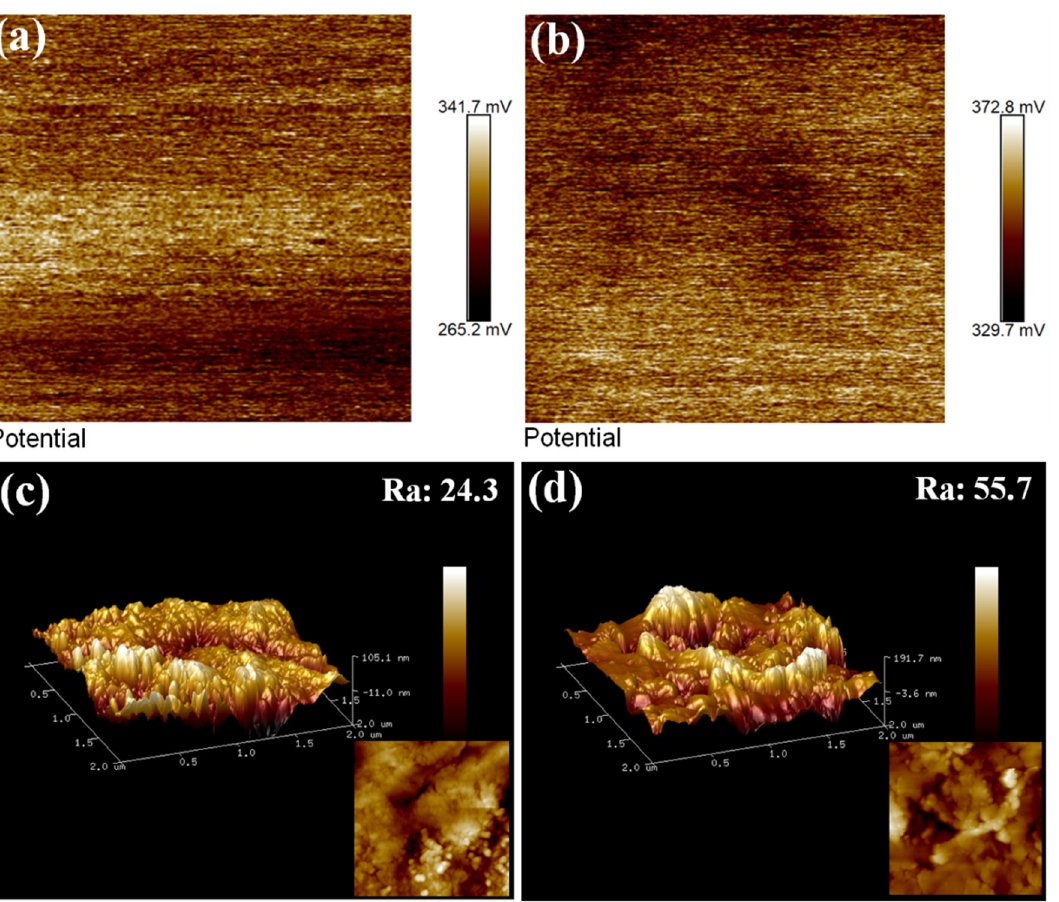
Figure 9. Surface potentials of ZIF-8/MO-PPy@CelF with 17.4% ( a ) and 31.8% ( b ) ZIF-8 deposition ratios; Surface roughness values of ZIF-8/MO-PPy@CelF with 17.4% ( c ) and 31.8% ( d ) ZIF-8 deposition ratios.